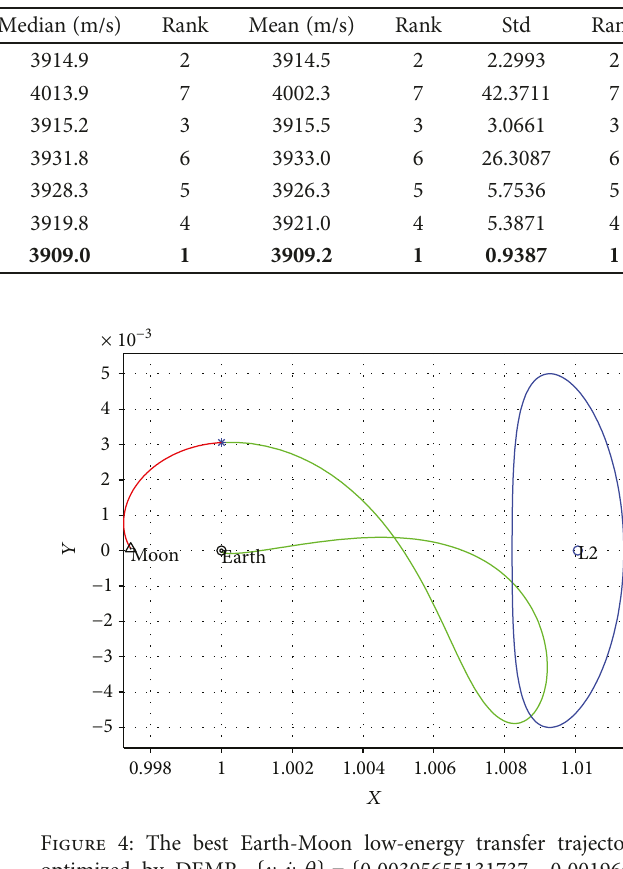
Table 3: Results for Earth-Moon low-energy transfer trajectory optimization in two-dimensional space.